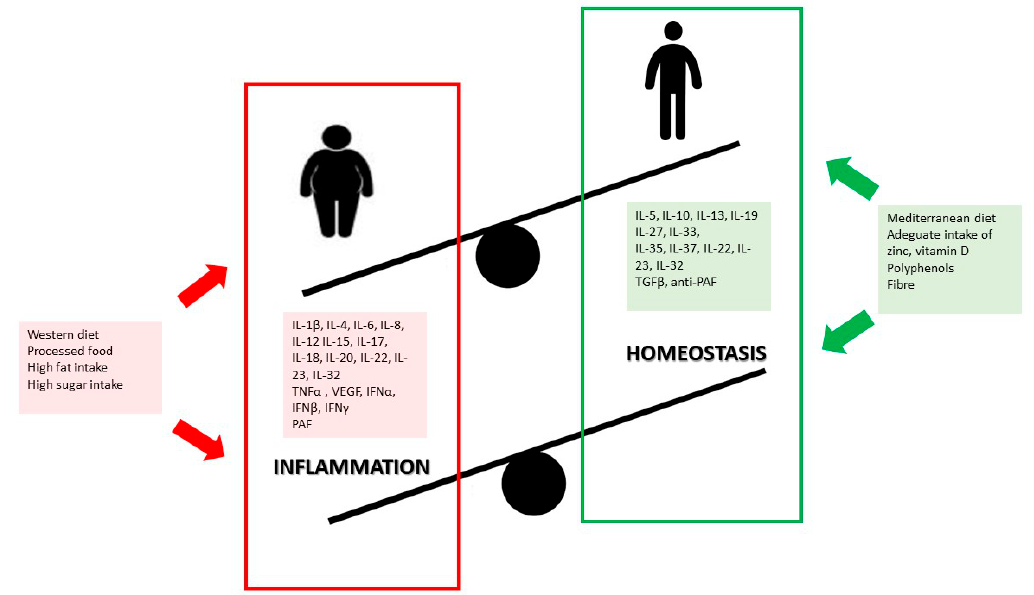
ff ects of diet in